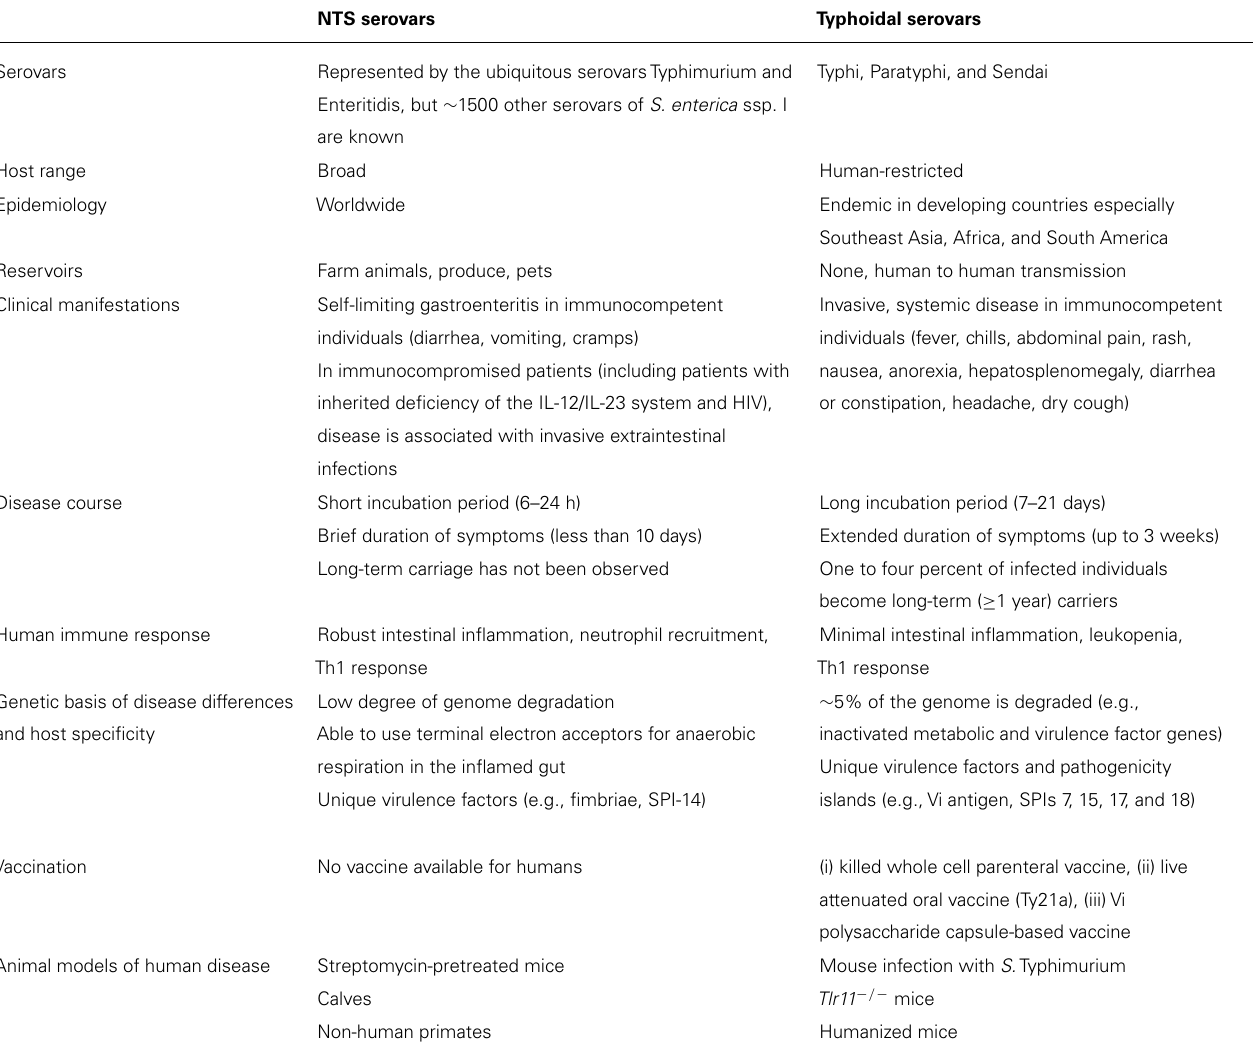
Table 1 | Summary of the differences between NTS and typhoidal serovars associated with disease in